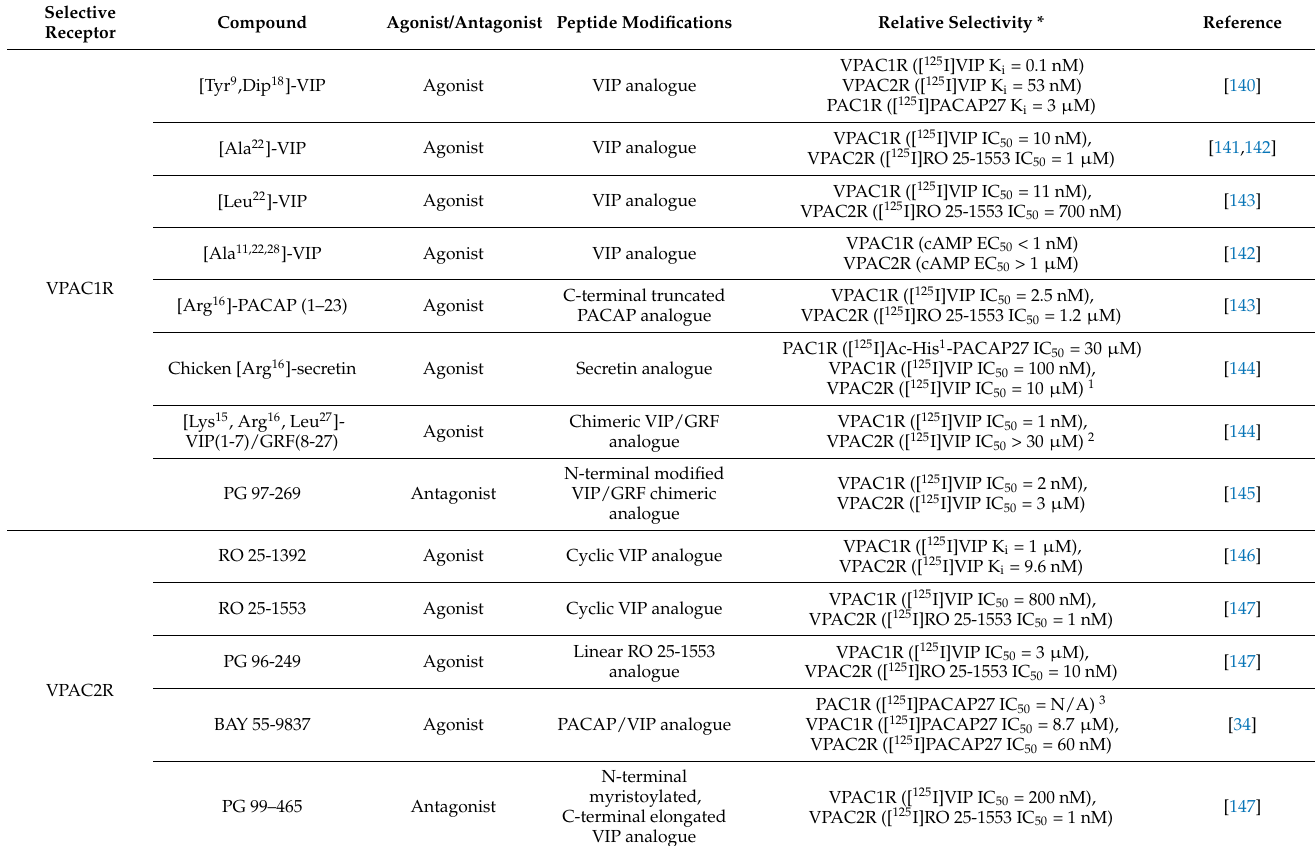
Table 2. VPAC1R, VPAC2R, or PAC1R selective peptide analogues. Selective